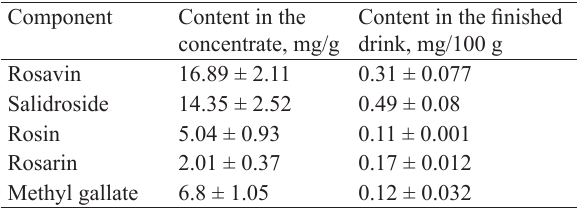
Table 2 Biologically active substances in the functional whey drink fortified with Rhodiola rosea concentrate